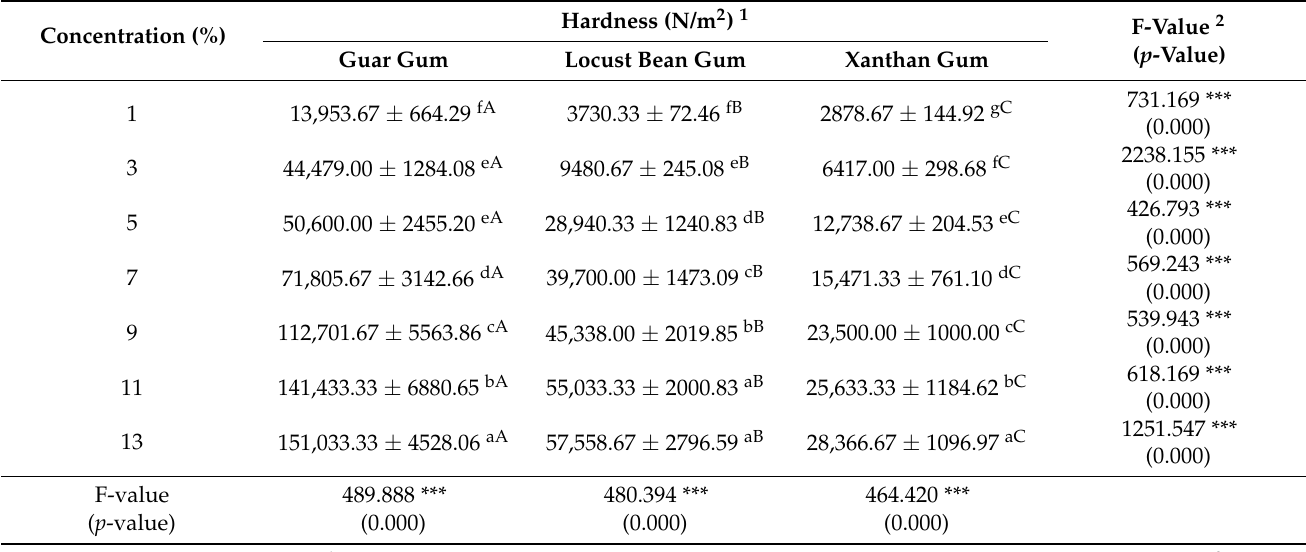
Table 3. Hardness of Kaniwa mousse according to gelling